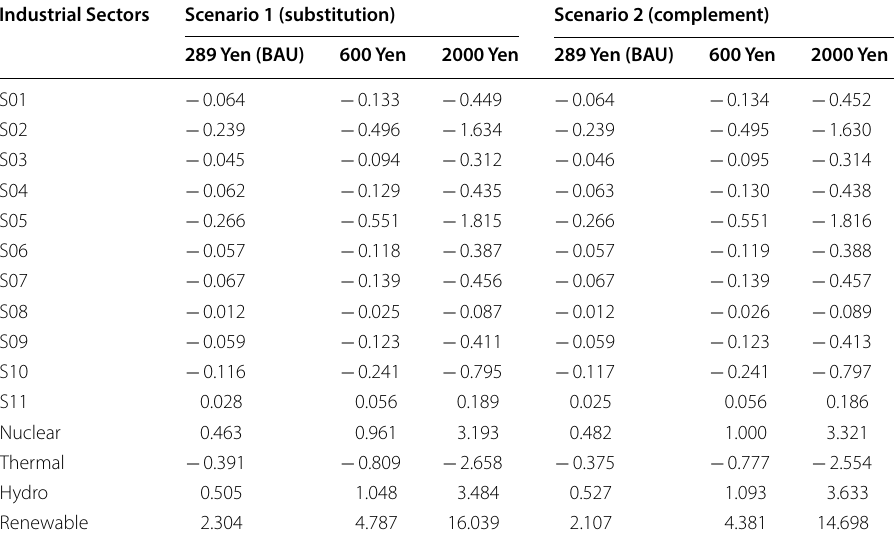
S01–S11 are the identifying numbers indicating industrial sectors shown in Table 1